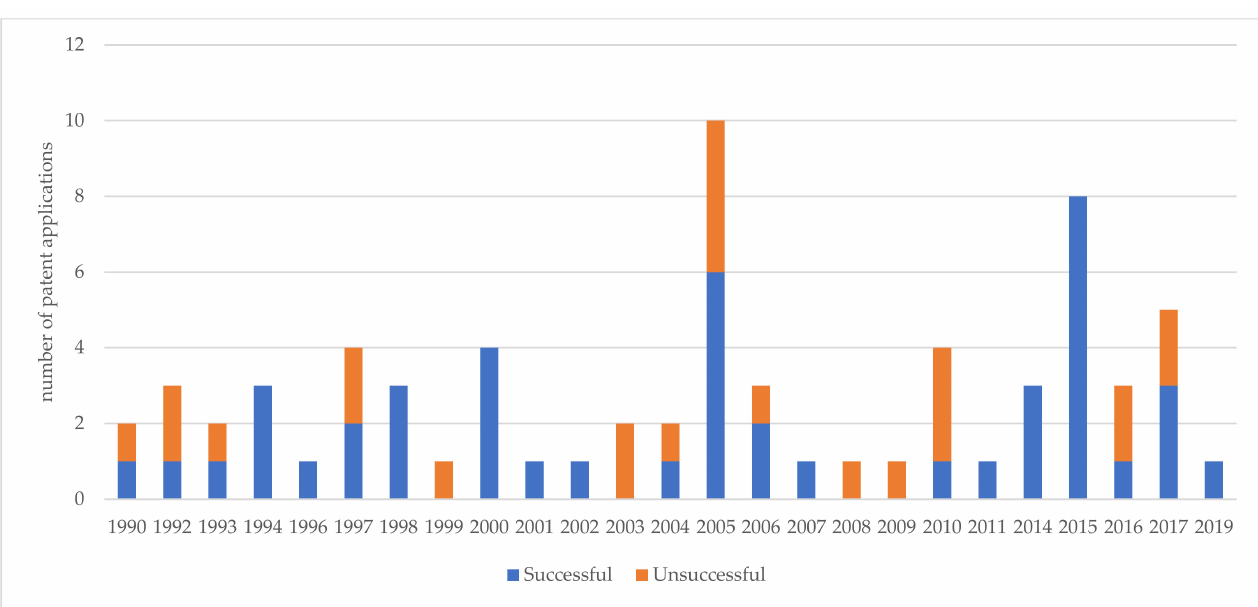
Figure 2. Patent applications in the field of electricity metering submitted to Polish Patent Office (1990–2020).